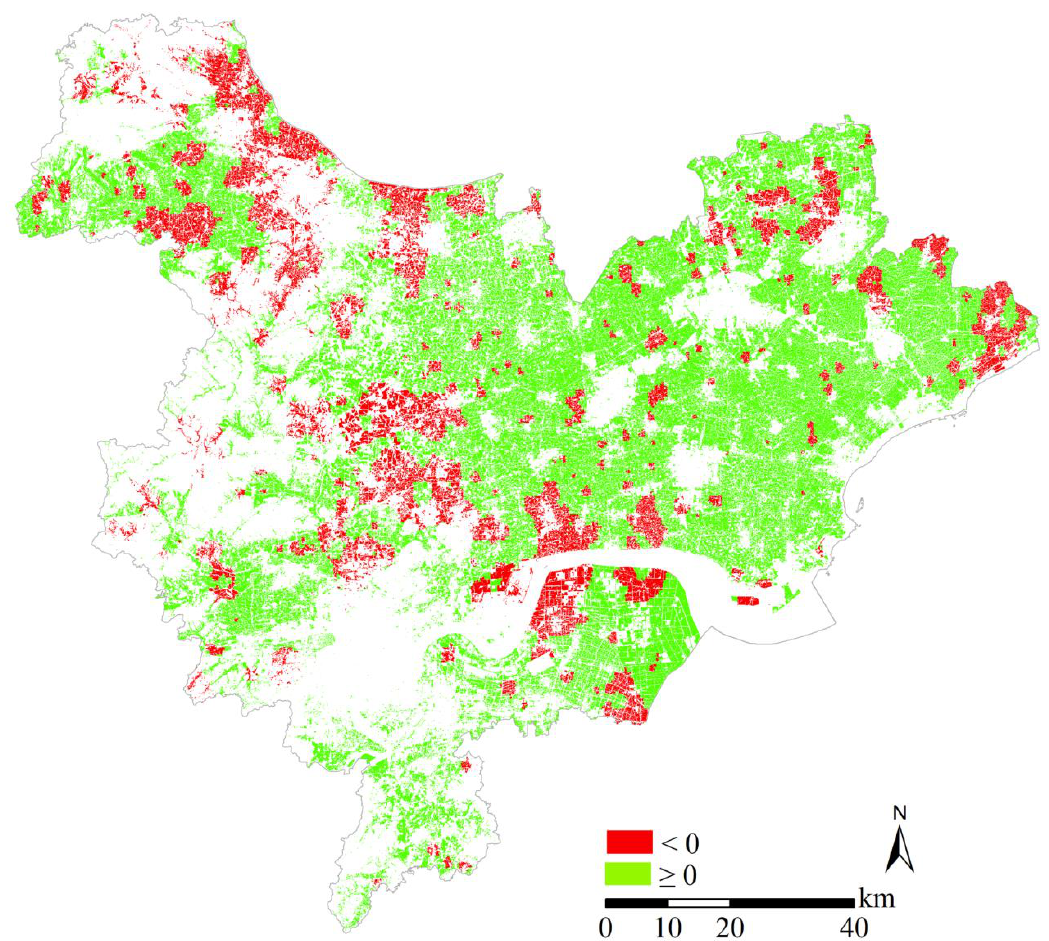
Figure 4. The variation in the cultivated land quality index from 2017 to 2020.